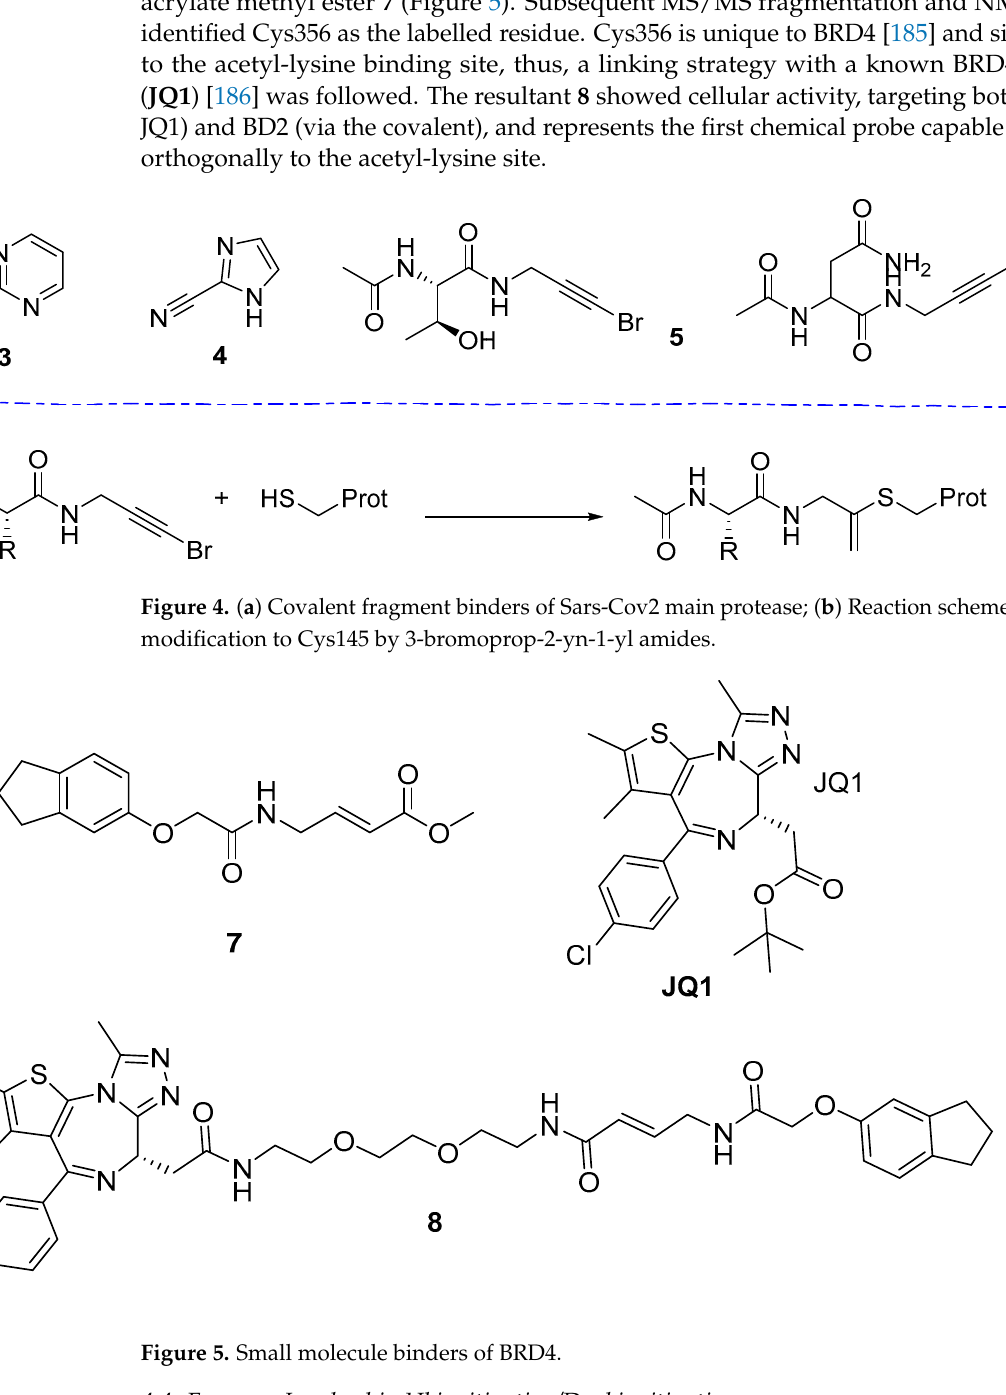
Figure 5. Small molecule binders of BRD4.